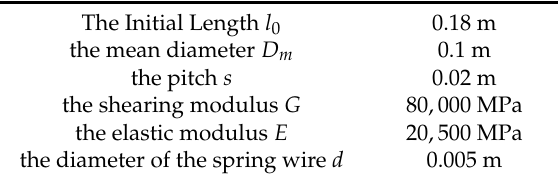
Table 1. The parameters of the equivalent spring of the